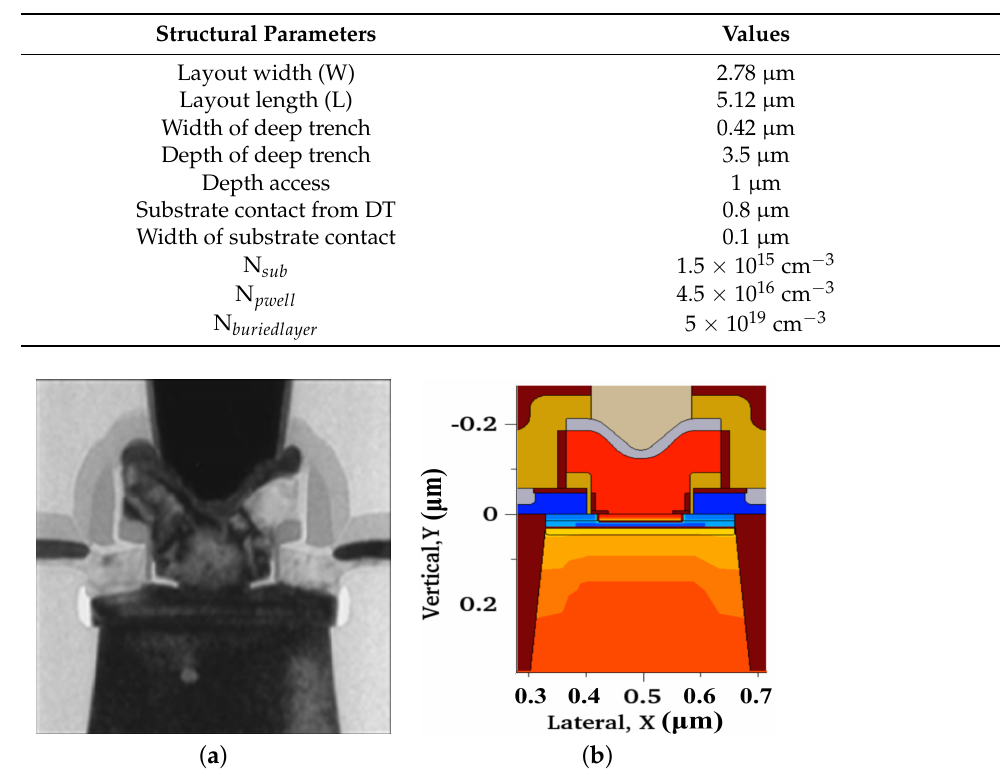
Table 1. 55 nm BICMOS technological data.